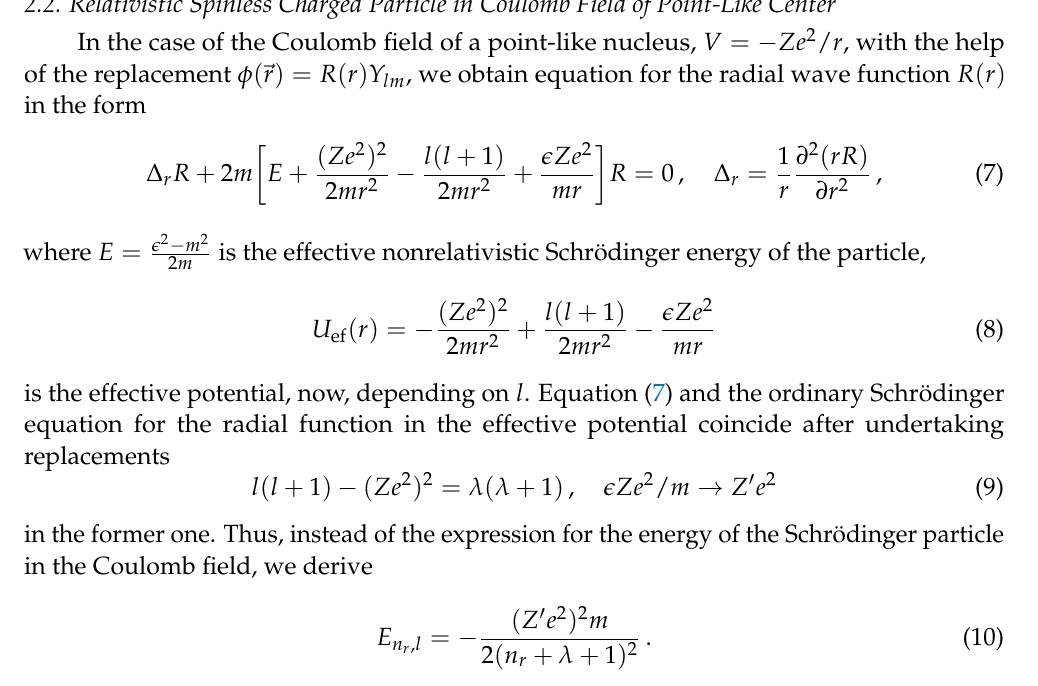
Figure 2. Illustration of the deformation of the upper and lower continua in a strong external electric field (the boundaries of the continua are shaded). Electrons that belong to the vacuum shell in the upper continuum fill the cross-hatched region. The states below the curve (cid:101) − / m = V ( r ) / m − 1 form the unobservable Dirac sea. The quantity W shows an artificial cutoff